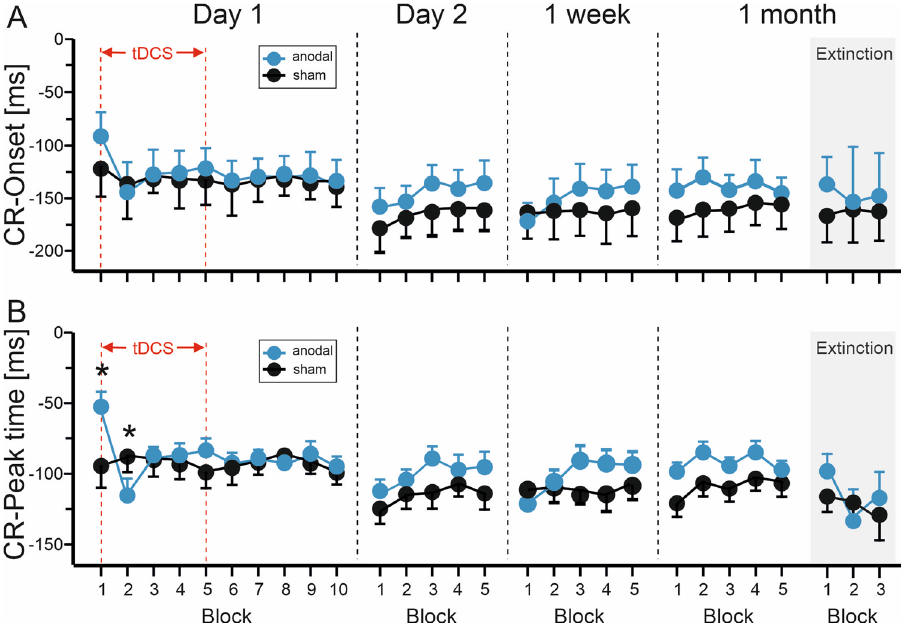
Figure 4. Group mean and standard errors (SE) of CR onset ( A ) and peak time ( B ) latencies on days 1, 2, 8 (1 week) and 29 (1 month). Ten blocks a 10 paired CS–US trials were presented on day 1, five blocks a 10 paired CS–US trials on days 2, 8 and 29. In addition, 3 blocks a 10 CS-only extinction trials were presented on day 29. Negative values refer to the time prior to the onset of the US (air-puff) set as 0 ms. Note that the number of participants per block varies because of lack of CRs in individual blocks. Blue filled circles = anodal group, filled black circles = sham group. * indicates significant effects in post-hoc pairwise comparisons.